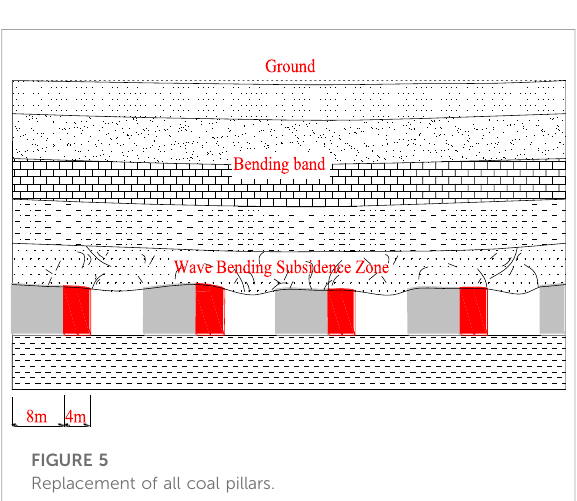
FIGURE 5 Replacement of all coal